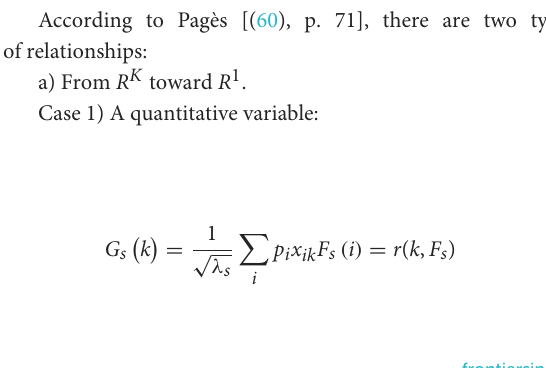
employed because it allows both types of variables to